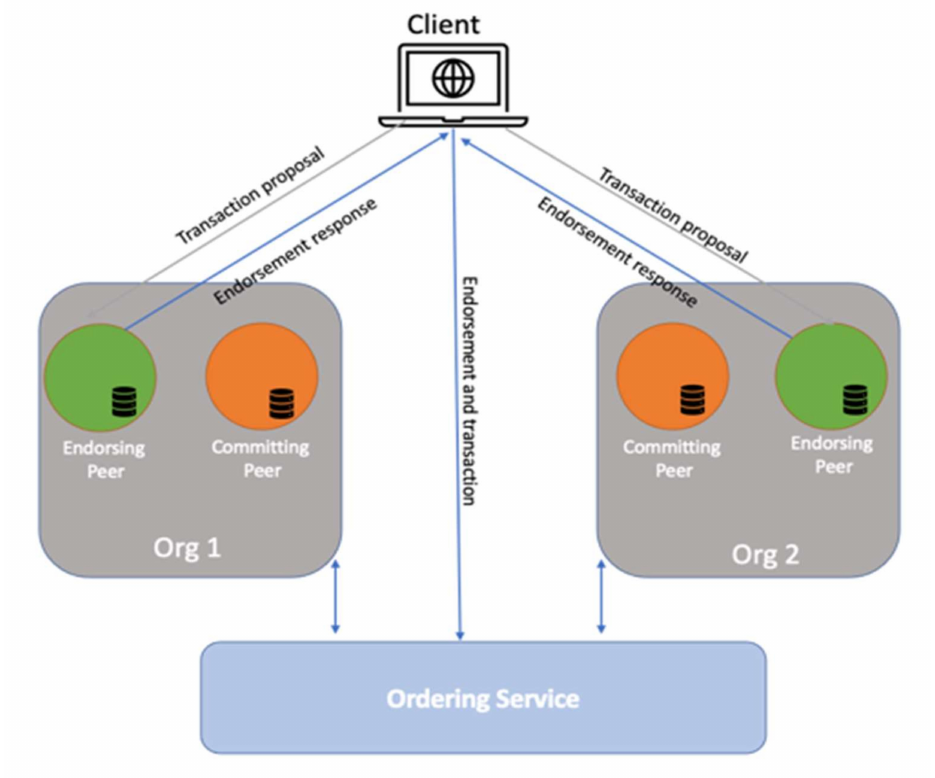
Figure 3. Illustrating the major blockchain